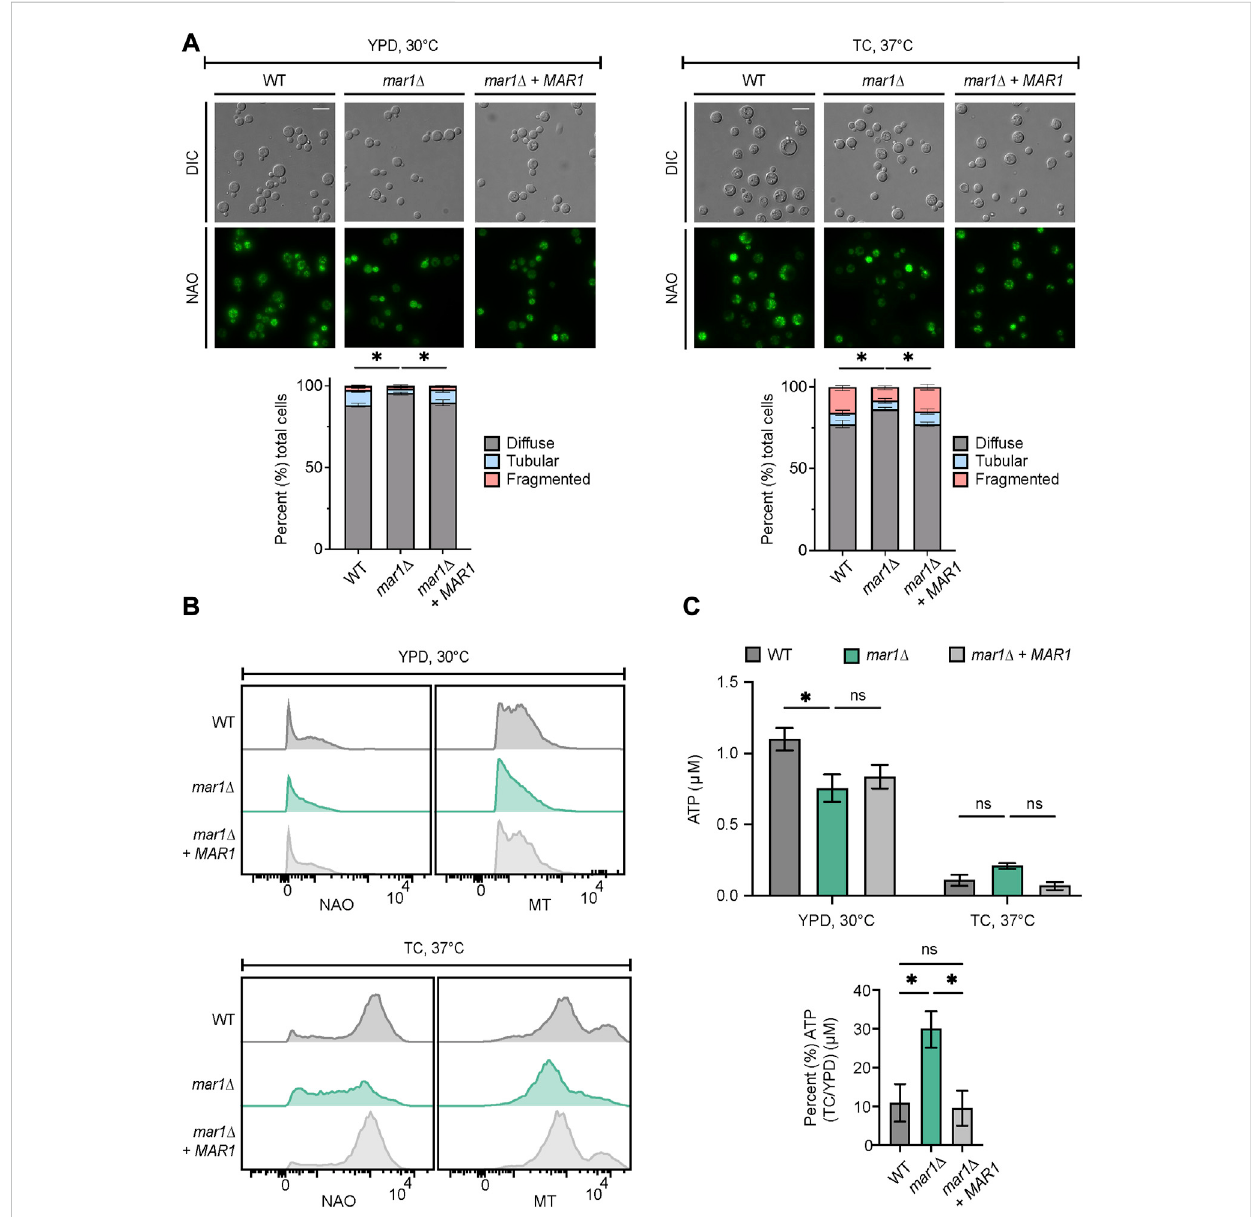
FIGURE 4 Mar1contributionstomitochondrialhomeostasis. (A) MitochondrialmorphologiesoftheWTstrain,the mar1 Δ mutantstrain,andthe mar1 Δ + MAR1 complemented strain were assessed following incubation in YPD medium at 30 ° C (left) and TC medium at 37 ° C (right). Mitochondria were stained with nonyl acridine orange (NAO) and subsequently imaged by epi fl uorescence microscopy (63x scale bar, 10 μ m). Data are presented as the proportion of cells in each sample with diffuse, tubular, and fragmented morphologies. A minimum of 200 cells were analyzed across three biological replicates ( n =3).ErrorbarsrepresenttheSEM.Statisticallysigni fi cantdifferencesinthepercentageofcellsineachstrainwithdiffusemorphologyweredetermined using a one-way ANOVA and the Tukey-Kramer test (*, p < 0.05). DIC, differential interference contrast. (B) Mitochondrial mass and mitochondrial membranepotential ofthe WT strain, the mar1 Δ mutant strain, and the mar1 Δ + MAR1 complemented strain were measured following incubation inYPD medium at 30 ° C (top) and TC medium at 37 ° C (bottom). Mitochondria were co-stained with NAO, as a marker of mitochondrial mass, MitoTracker TM Red CMXRos (MT), as a marker of mitochondrial membrane potential, and Sytox TM Blue (SB). Flow cytometry was used to quantify staining intensity. Relevant events were gated for live cells (FSC vs. SSC and SSC vs. SB), single cells (FSC-H vs. FSC-A), and positive labelling (SSC vs. NAO/MT, determined using unstained cells as negative controls). Data are represented as histograms with mean fl uorescence intensity on the x-axis and cell number of the y-axis. Experiment was repeated three times to ensure reproducibility. (C) Total cellular ATP was measured for the WT strain, the mar1 Δ mutant strain, and the mar1 Δ + MAR1 complementedstrainfollowingincubationinYPDmediumat30 ° CandTCmediumat37 ° C.Normalizedtotalcelllysateswereanalyzedfor totalcellularATPusinga fi re fl yluciferasebioluminescentassay.DataarepresentedastheaverageATP( μ M)persample(top)andthepercentageofATPin TC medium at 37 ° C compared to YPD medium at 30 ° C ( μ M) (bottom) across two biological replicates ( n = 2). Error bars represent the SEM. Statistical signi fi cance was determined using two-way and one-way ANOVA and the Tukey-Kramer test (*, p < 0.05; ns, not signi fi